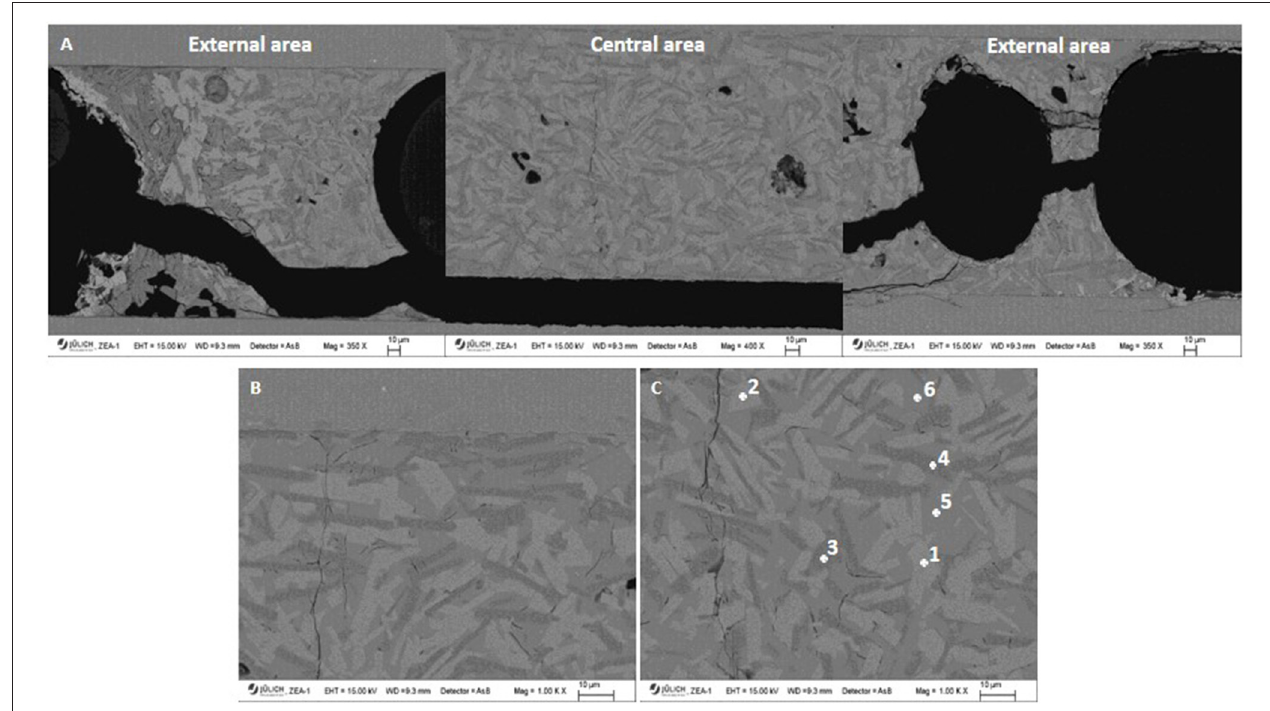
FIGURE 4 | SEM images of the joint Crofer22APU-glass-ceramic 7.5B(Ba) after sealing (black void due to the opening of the sample for inspection). (A) General image of the joint showing outer and central areas. (B) Detail of the joint between steel and sealant. (C) Microstructure of the seal and EDX elemental analysis.